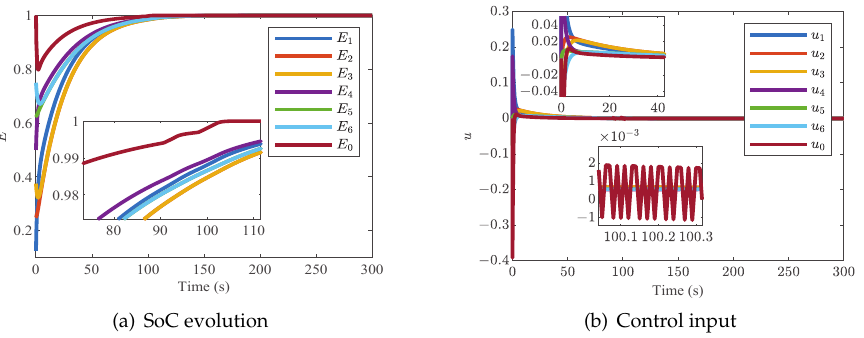
Figure 5. SoC evolution and control input of the system under the distributed charging strategy with a WE-based smart leader in Case 2.